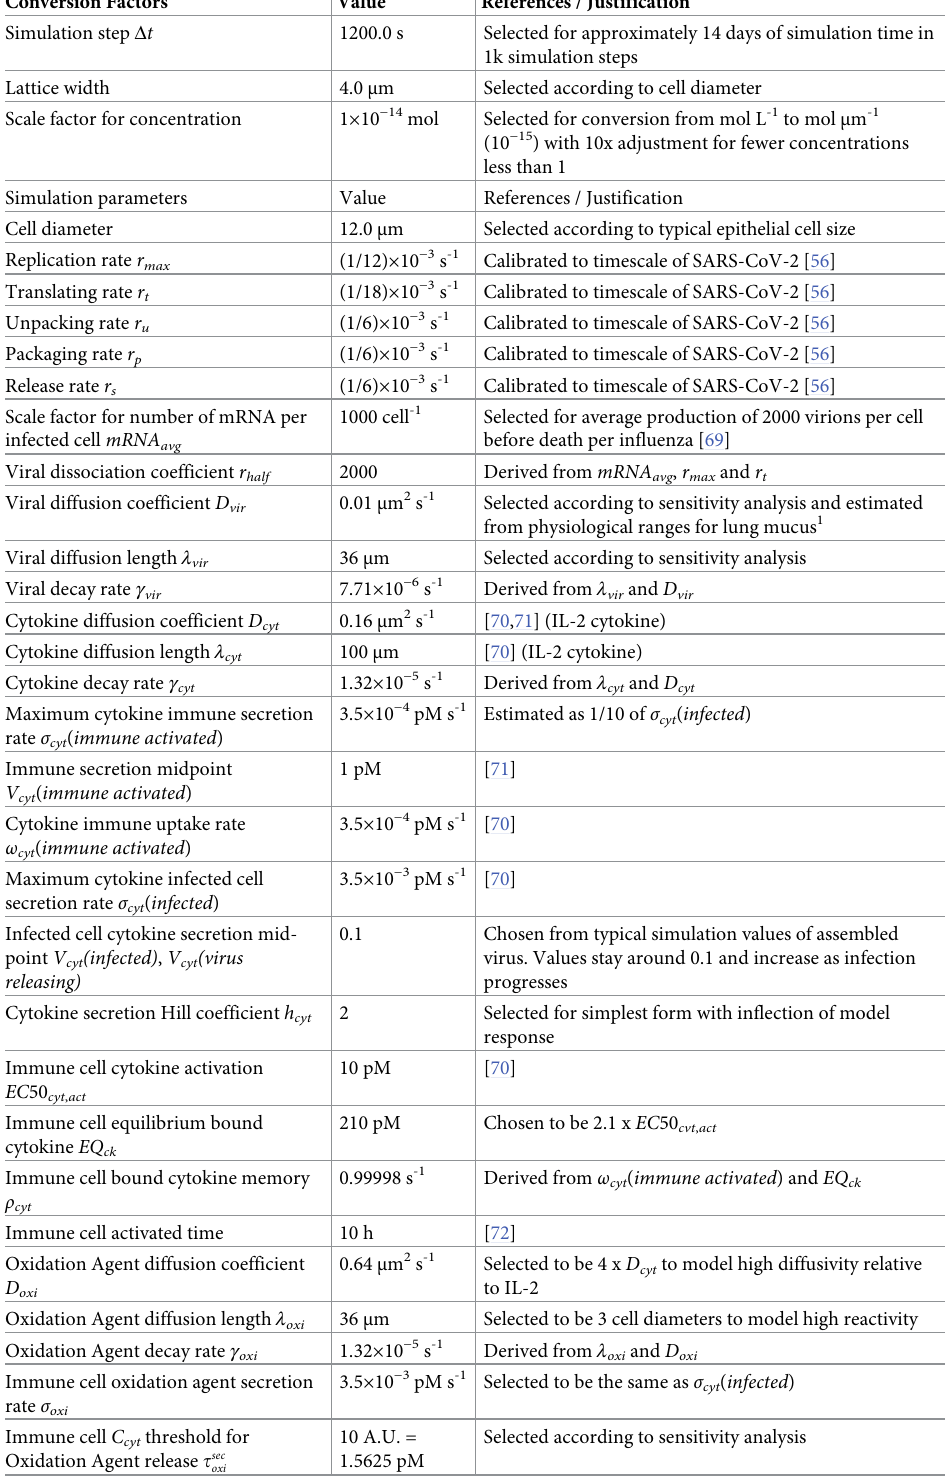
Table 1. Parameter values in baseline parameter